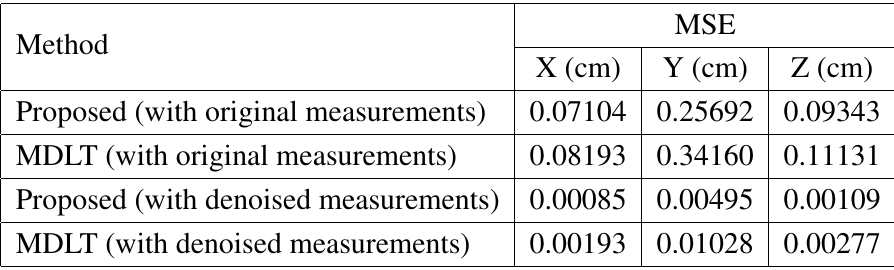
Table 3. The MSE values of backprojection of the 2D test